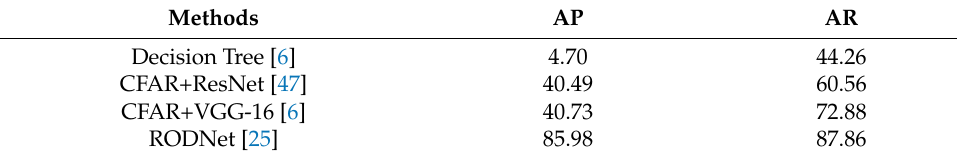
Table 1. Radar object detection performance evaluated on CRUW dataset.